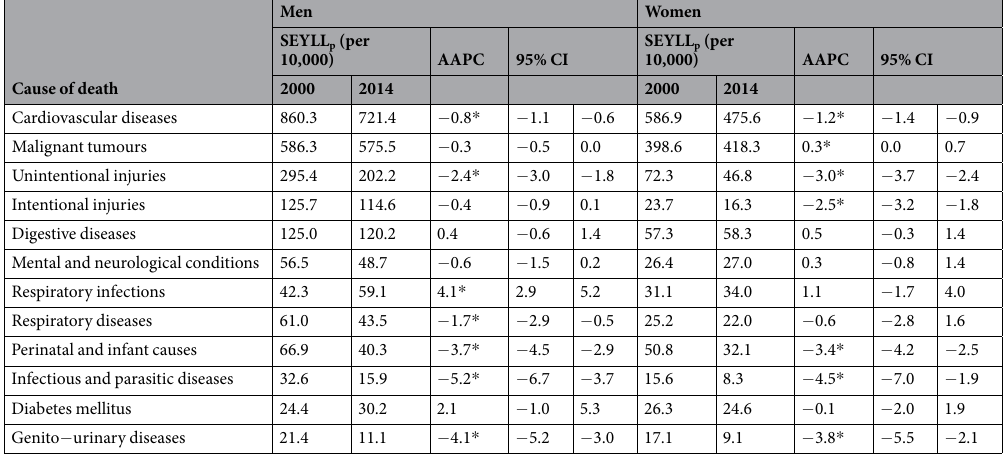
Table 2. Standard expected years of life lost by sex and main groups, Poland, 2000–2014. SEYLL p - Standard Expected Years of life Lost per living persons. AAPC - Average Annual Percentage Change. CI–Confidence Interval. * p <